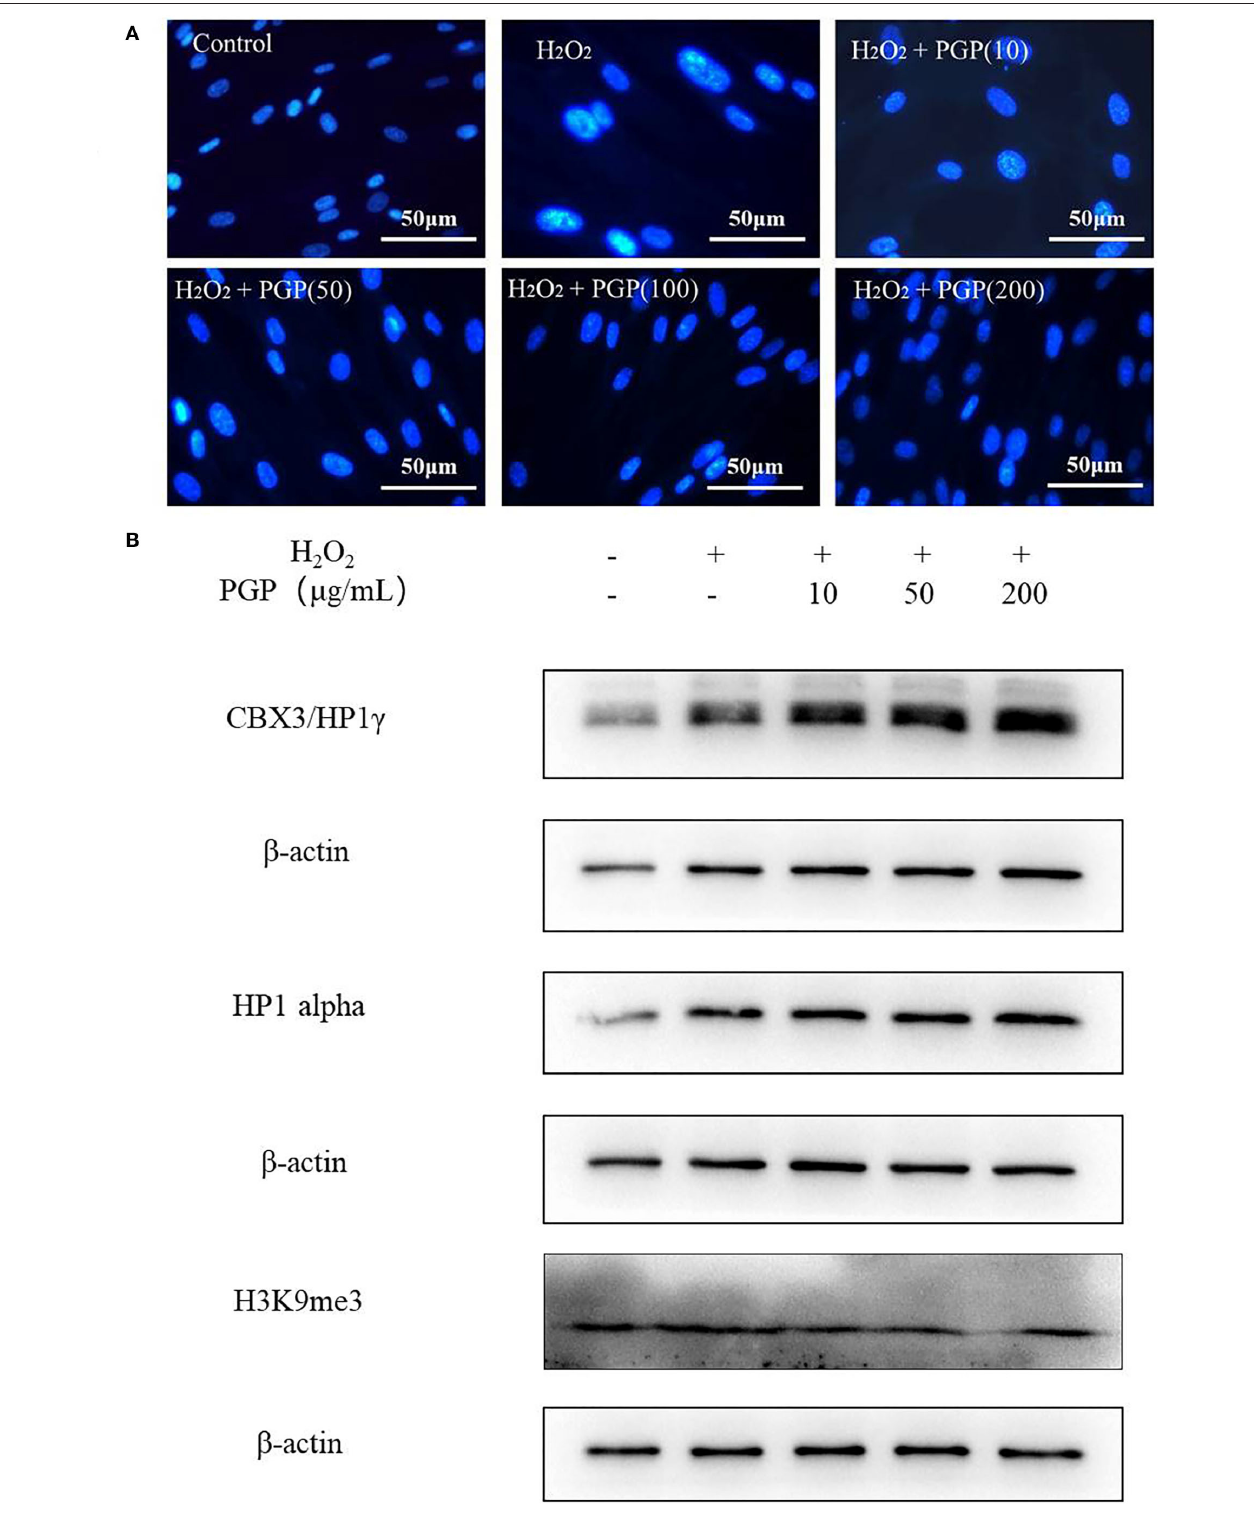
FIGURE 6 | Senescence-associated heterochromatic foci (SAHF) formation (A) and the expression levels of three proteins (HP1a, HP1g, and H3k9me3) (B) in the nucleus of senescent 2BS cells visualized by DAPI staining. Permeabilize the cells by incubating the coverslips in 0.2% (v/v) Triton-X 100 in PBS (pH 7.3) for 5min at room temperature. Stain SAHF by incubating the coverslips with 0.15 µ g/ml final concentration of DAPI diluted in 3% (w/v) BSA in PBS, pH 7.3 for 3min. After the slides have dried, observe SAHF using a fluorescent microscope.